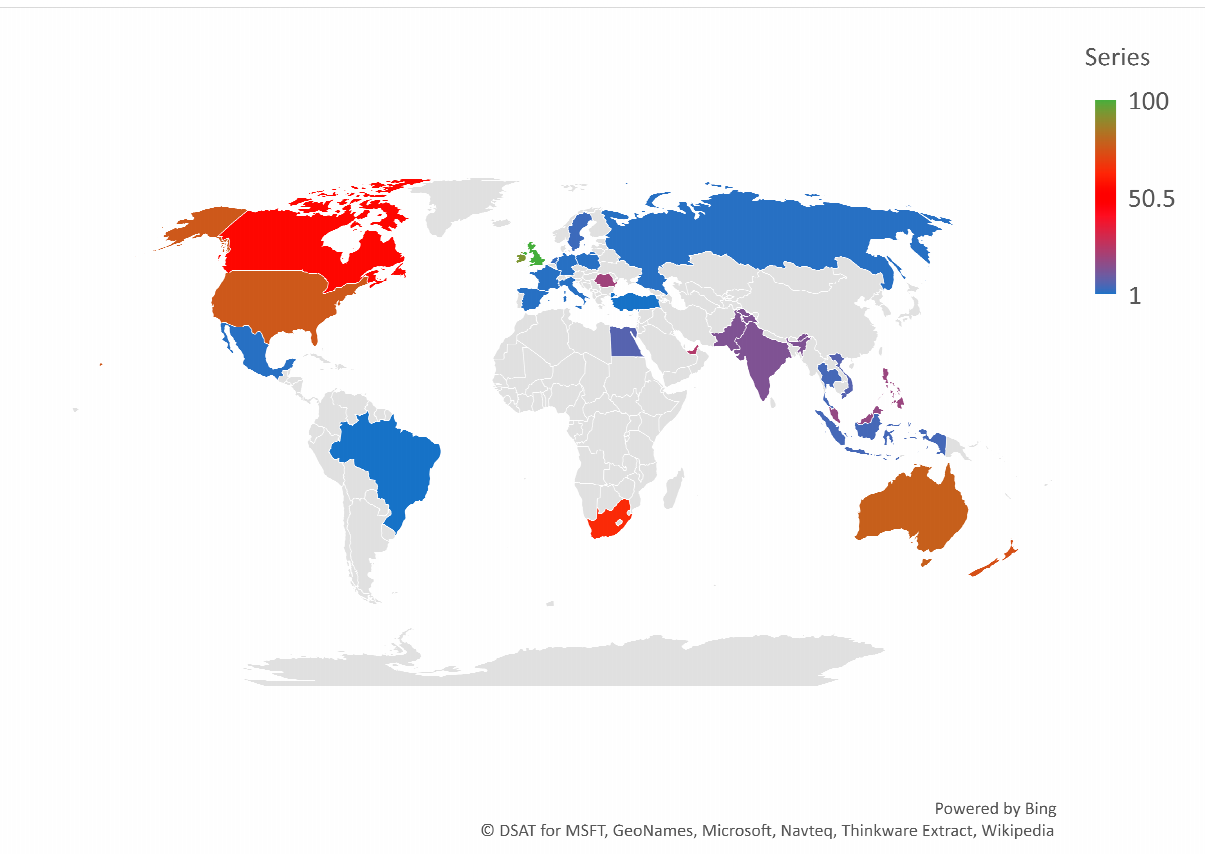
Figure 3. The geographical mapping of the countries with SVIs greater than or equal to 1. The top ten countries with the greatest SVIs are depicted in Table 1. These countries were all on the list of the top 50 countries with the highest gross domestic product (GDP); 80% in the Global North with 40% in Europe [37,38]. Table 1. Top Ten Countries with the greatest SVI.